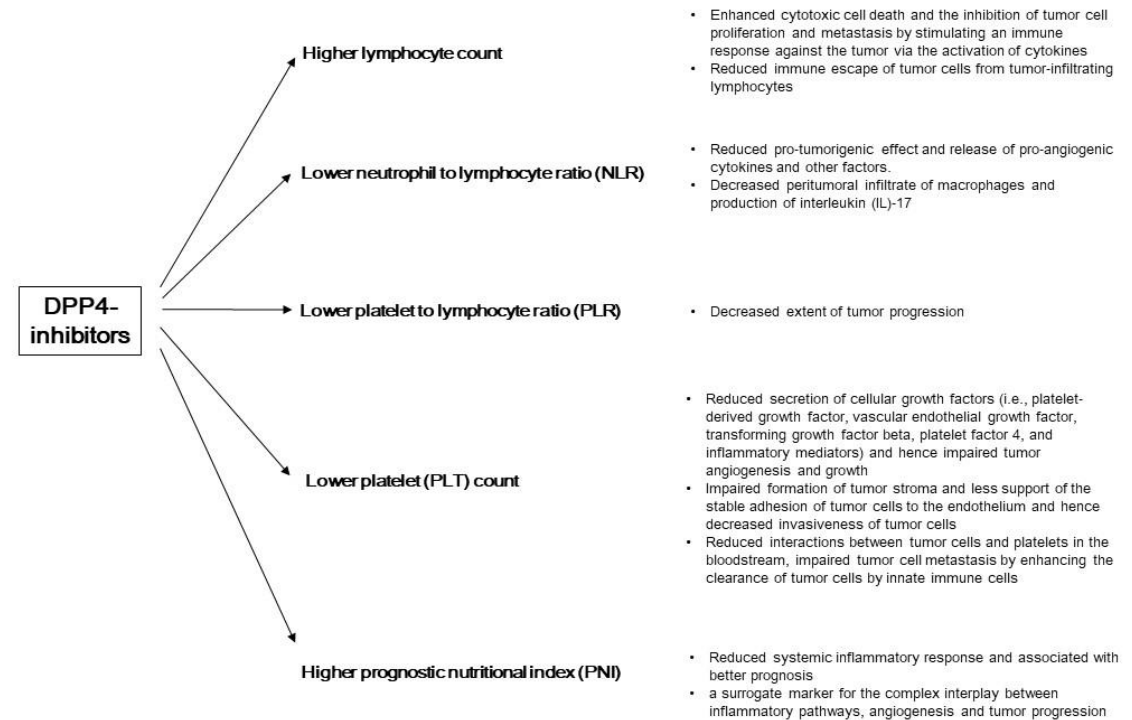
Figure 5. A summary of the findings from this study on the changes in certain immune cells and systemic inflammatory responses in CRC patients treated with DPP4-inhibitors and the subsequent mechanisms associated with better prognosis.